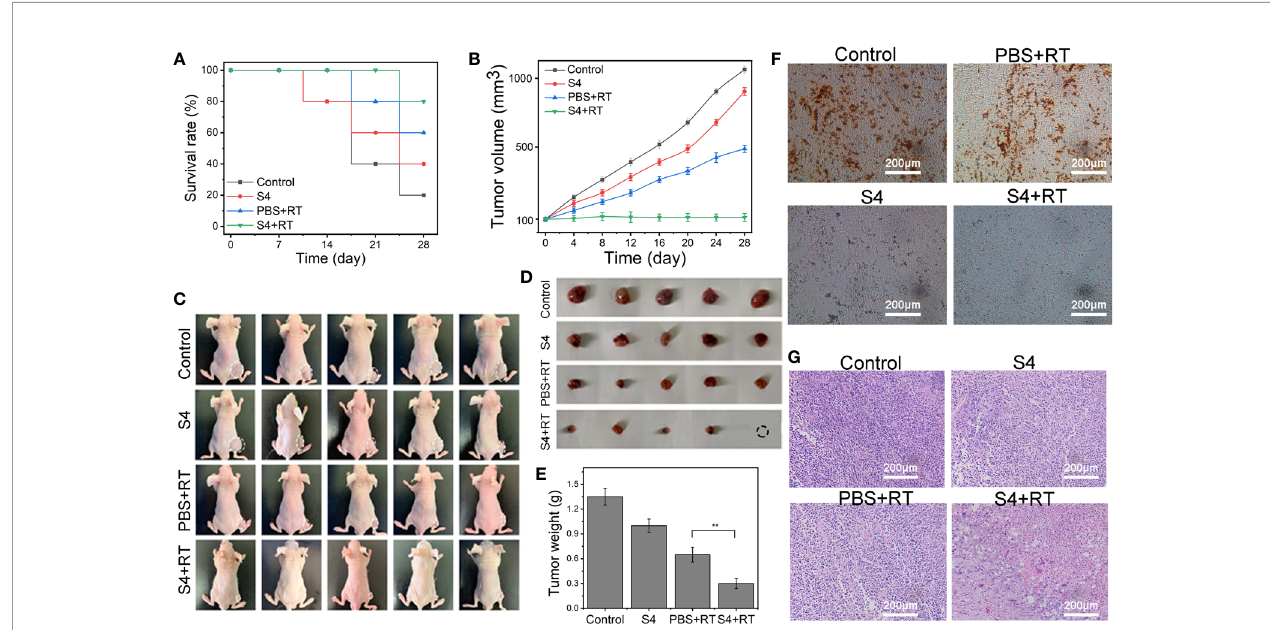
FIGURE 5 | Effect of S4 treatment plus irradiation on tumor growth in ESCC xenograft model. An ESCC xenograft model was established in male BALB/c nude mice via subcutaneous injection with ECA-109 cells. Mice were randomly divided into four groups (n=5 per group): control (PBS vehicle), S4 (S4 treatment), PBS+RT (PBS vehicle plus X-ray irradiation at 4 Gy), and S4+RT (S4 treatment plus X-ray irradiation at 4 Gy). (A) The survival rate was recorded at the end of each week for four weeks. (B) Tumor volume was examined every four days for 28 days. (C) Images of each animal at the end of the study (death or at day 28 post-treatment) were shown. (D, E) Tumor samples were collected and weighed immediately after death or at day 28 post-treatment. Tumor tissue samples were stained for (F) CAIX using immunohistochemistry and (G) H&E (pathological changes). ** P <